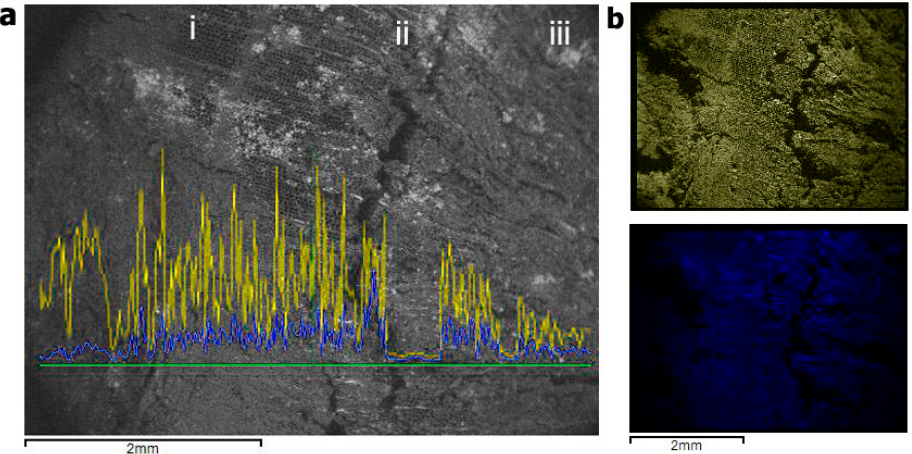
Figure 3. EDS Line-scan and mapping of a sample where all conditions coexisted. ( a ) Line scan of carbon (yellow) and oxygen (blue) (left to right the transition from charred to uncharred, i–iii); ( b ) mapping of carbon (yellow) and oxygen (blue).